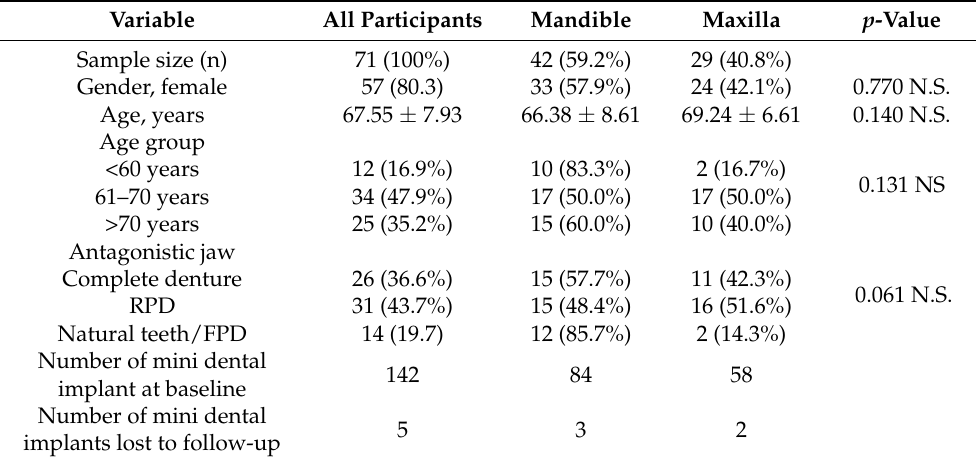
Table 1. Summary of the study variables and the significance the difference between the groups of the participants who completed a 5-year